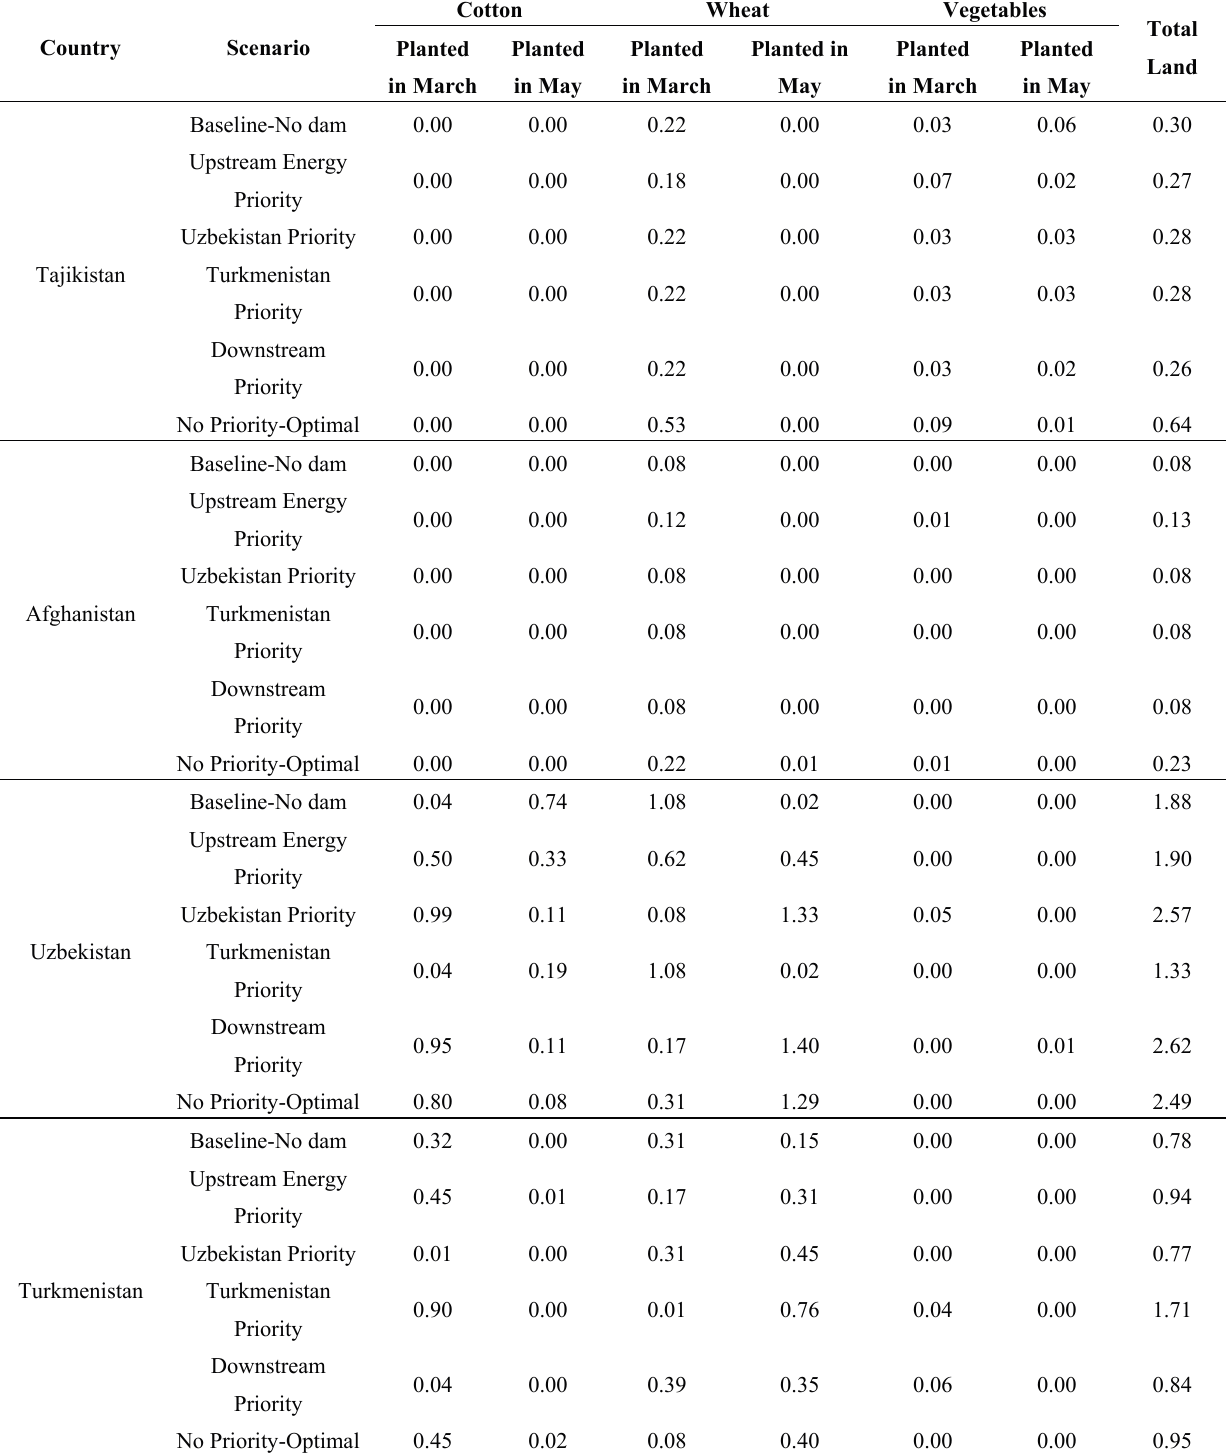
Table A1. Land under production by country, crop, season, and scenario, averaged over future years (millions of